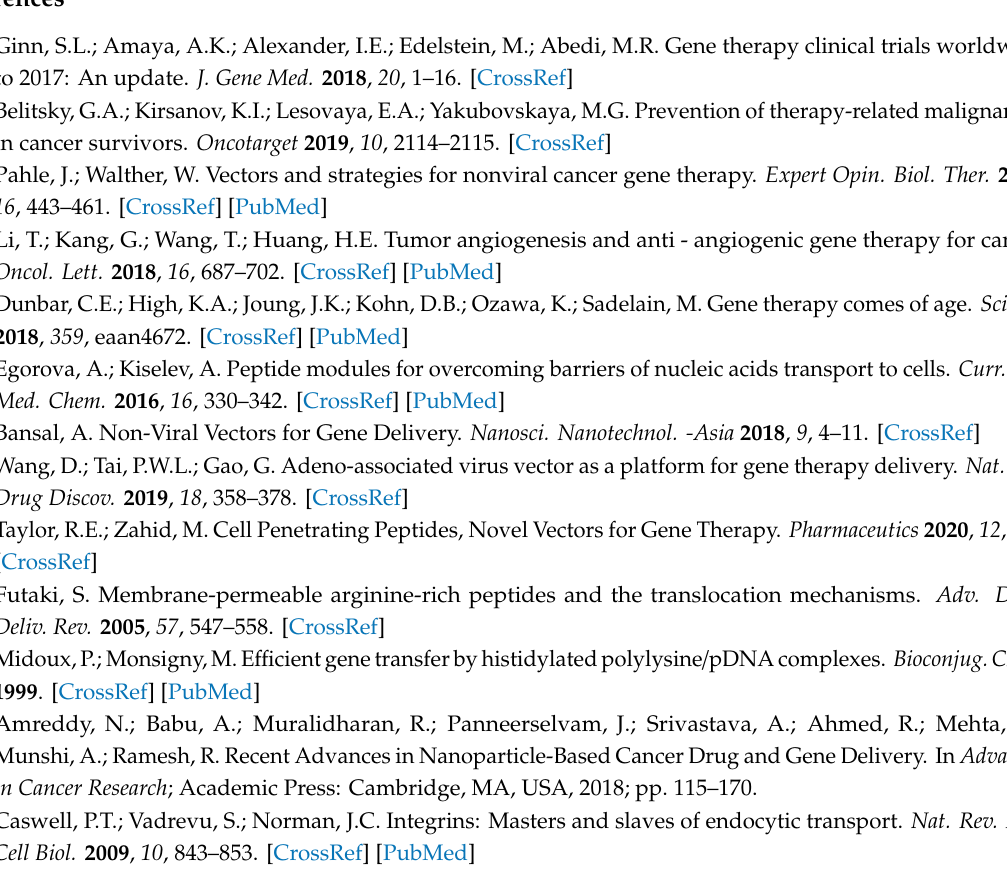
Figure S1: Detection of α v β 3 integrins on the surface of 293T, HeLa, PANC-1 cell lines by flow cytometry analysis, Figure S2: Cytotoxicity evaluation of free carriers in 293T, HeLa, PANC-1, and MDA-MB-231 cells by the Alamar blue assay, Figure S3: Typical MALDI TOF mass spectra of RGD0 and RGD1 peptides, Figure S4: SDS-PAGE results for RGD0 and RGD1 peptides, Figure S5: Typical HPLC results for RGD0 and RGD1 peptides, Figure S6: Free thiol groups measurement by Ellman’s assay after 24 h of RGD1 peptide cyclization, Table S1: Experimental and theoretical molecular masses of RGD0 and RGD1